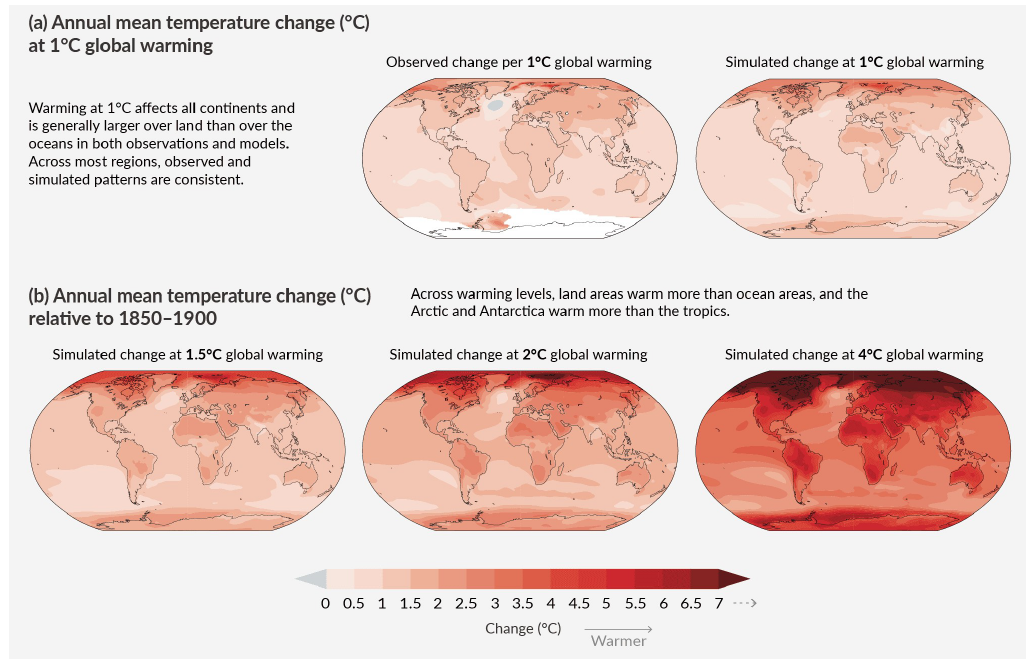
Figure 4. Geographical distribution of the global climate (a) comparing observation with simulation (b) for simulated changes in global warming at representative levels